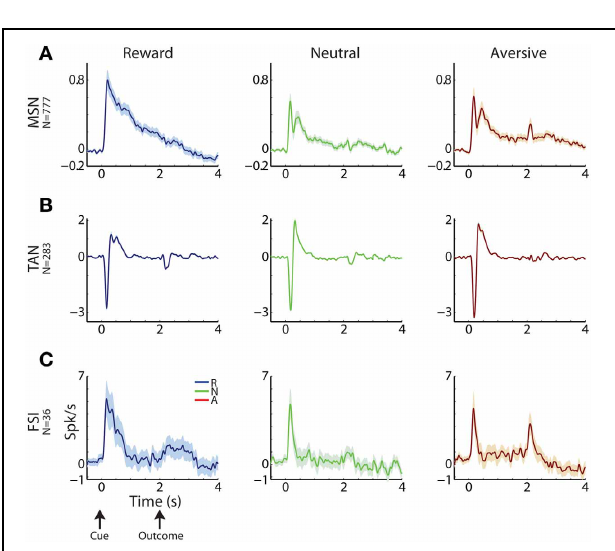
FIGURE 3 | Striatal MSNs, TANs, and FSIs display different response profiles. (A) MSN response profile. Average response ± SEM (solid line and envelope) to cue presentation (0s) and outcome delivery (2s). Ordinate: firing rate in Hz normalized by the ITI discharge rate. Blue, reward events; red, aversive events; green, neutral events. N is for number of cells. (B) TAN response profile. Same conventions as in (A) . (C) FSI response profile. Same conventions as in (A) .